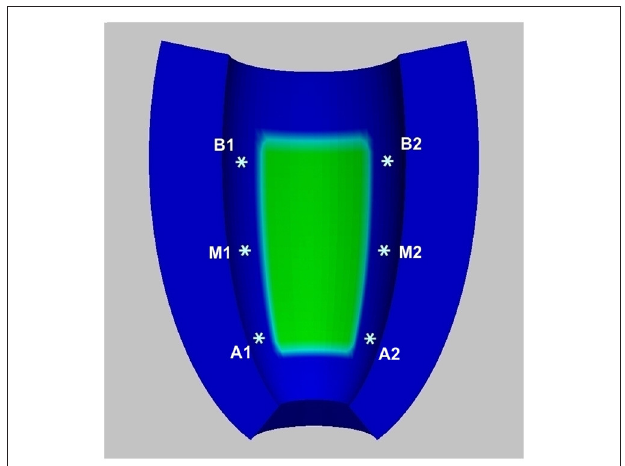
FIGURE 4 | Schematic representation of stimulation sites.